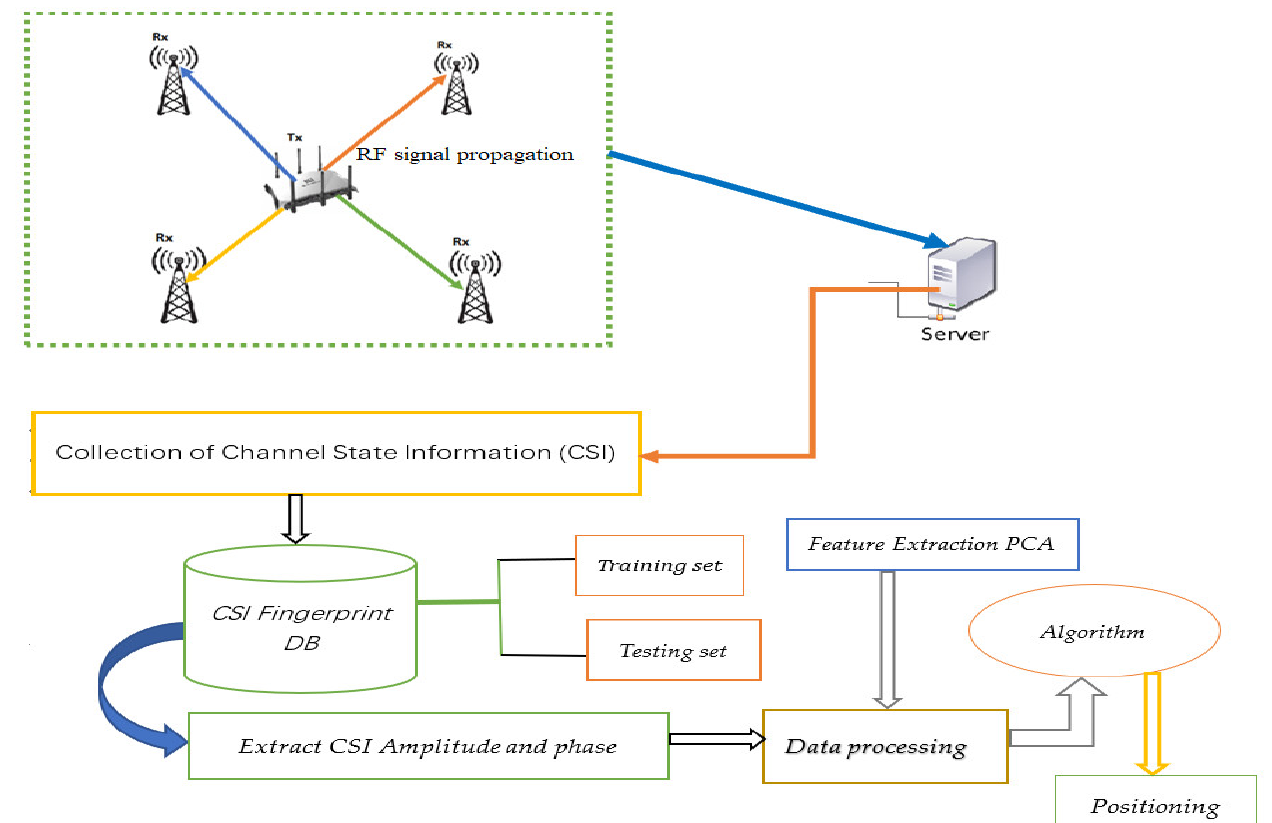
Figure 2. Proposed system architecture of CSI-based Fingerprint Database Construction for Indoor Positioning System.